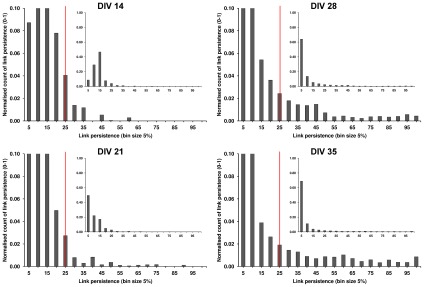
An increase in the number of links with high persistence as cultures aged.Each histogram shows the percentage of links found at each link persistence level for all cultures at each age (normalized count of links found at the persistence value, expressed as the percentage of transient networks (bursts) in which the link was found, bin size 5%, bin edges specify the end of each bin). Top left: DIV 14, bottom left: DIV 21, top right: DIV 28, bottom right: DIV 35. Red (solid) line is the link persistence threshold (link presence in at least 25% of the transient networks). The histograms are cropped to show the detailed distribution, inset histograms show the full scale. At DIV 21, many links were found infrequently (i.e. below the link persistence threshold). The more pronounced tail of the distribution as the cultures matured, reflected a significantly higher contribution of persistent links in the network's of mature cultures.